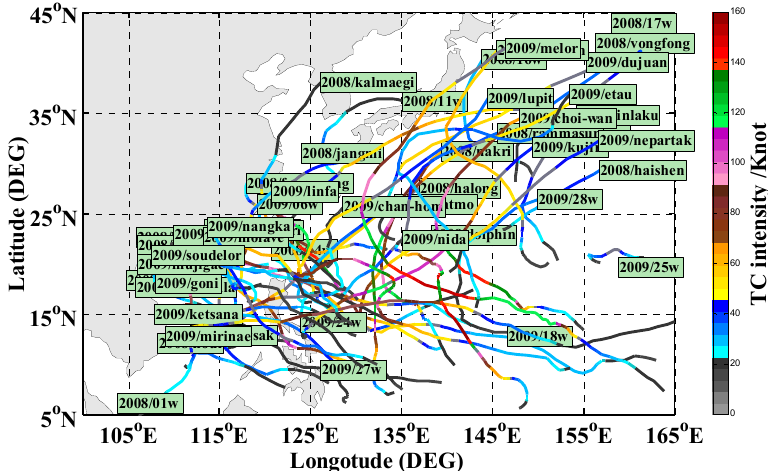
Figure 6. Same as Figure 1 but for cases from 2008 to 2009 typhoon season used in the independent tests. The green boxes represents the name of the cyclones.